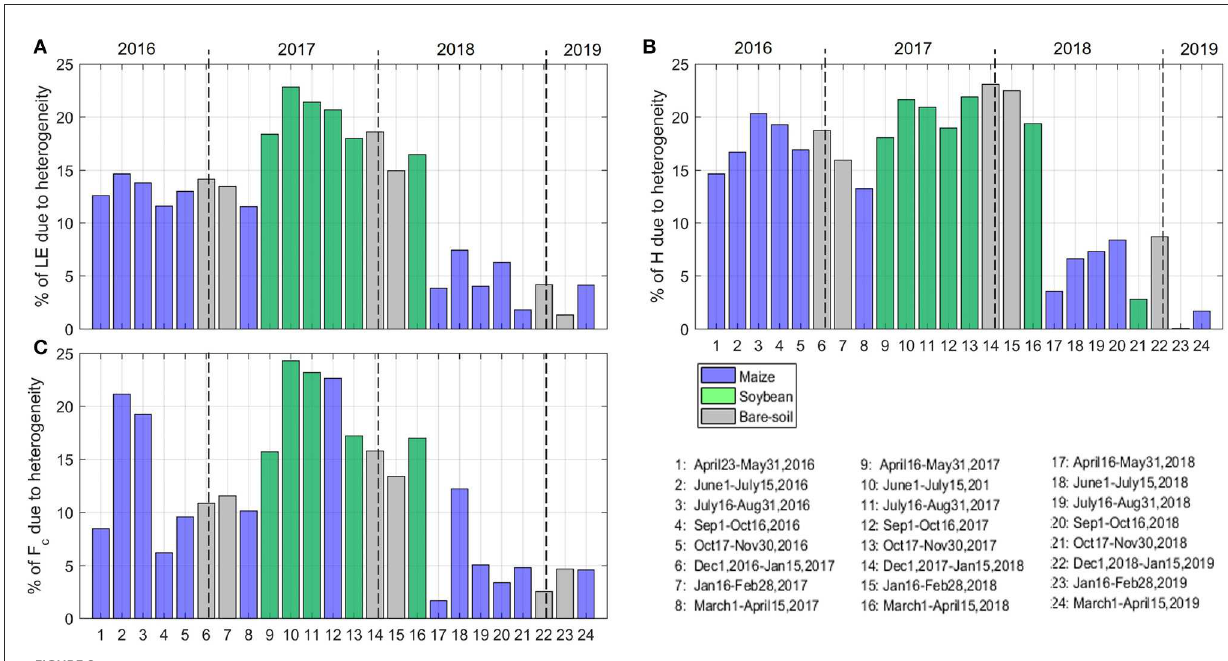
FIGURE8 Seasonal evolution of the percent contribution due to organized heterogeneity in 6-week windows, for (A) latent heat flux, LE ; (B) sensible heat flux, H ; and (C) carbon dioxide flux, F c . These plots show the difference between the response of a heterogeneous land cover mosaic and a hypothetical random assumption where φ m = φ s = 0.5. Dash vertical lines show the years of analysis.